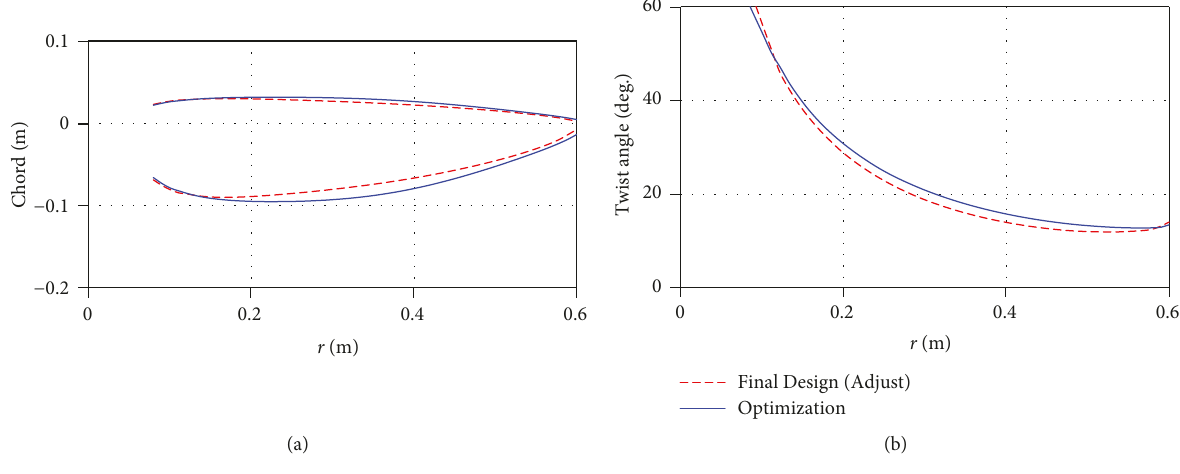
Figure 11: Comparison of geometry for optimization and fi nal design.